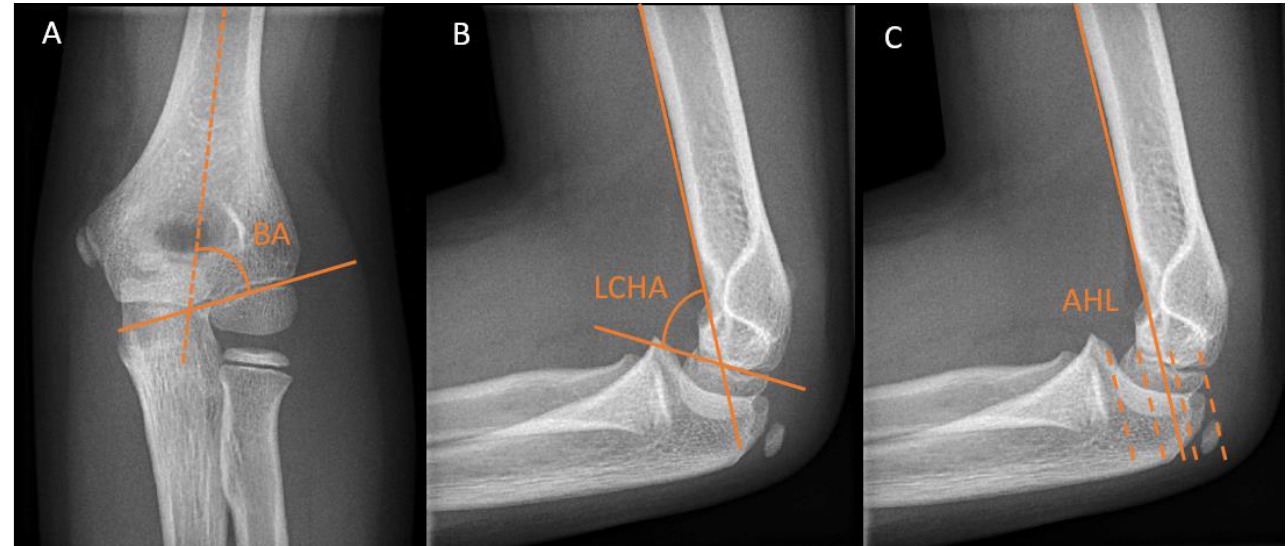
Figure 2. Distal humerus radiographic reference lines. ( A ) Baumann angle (BA) on an anteroposterior elbow view. ( B ) The lateral capitellohumeral angle (LCHA) on a lateral elbow view. ( C ) Anterior humeral line (AHL) on a lateral view. This line should pass between the two dotted lines in the middle.